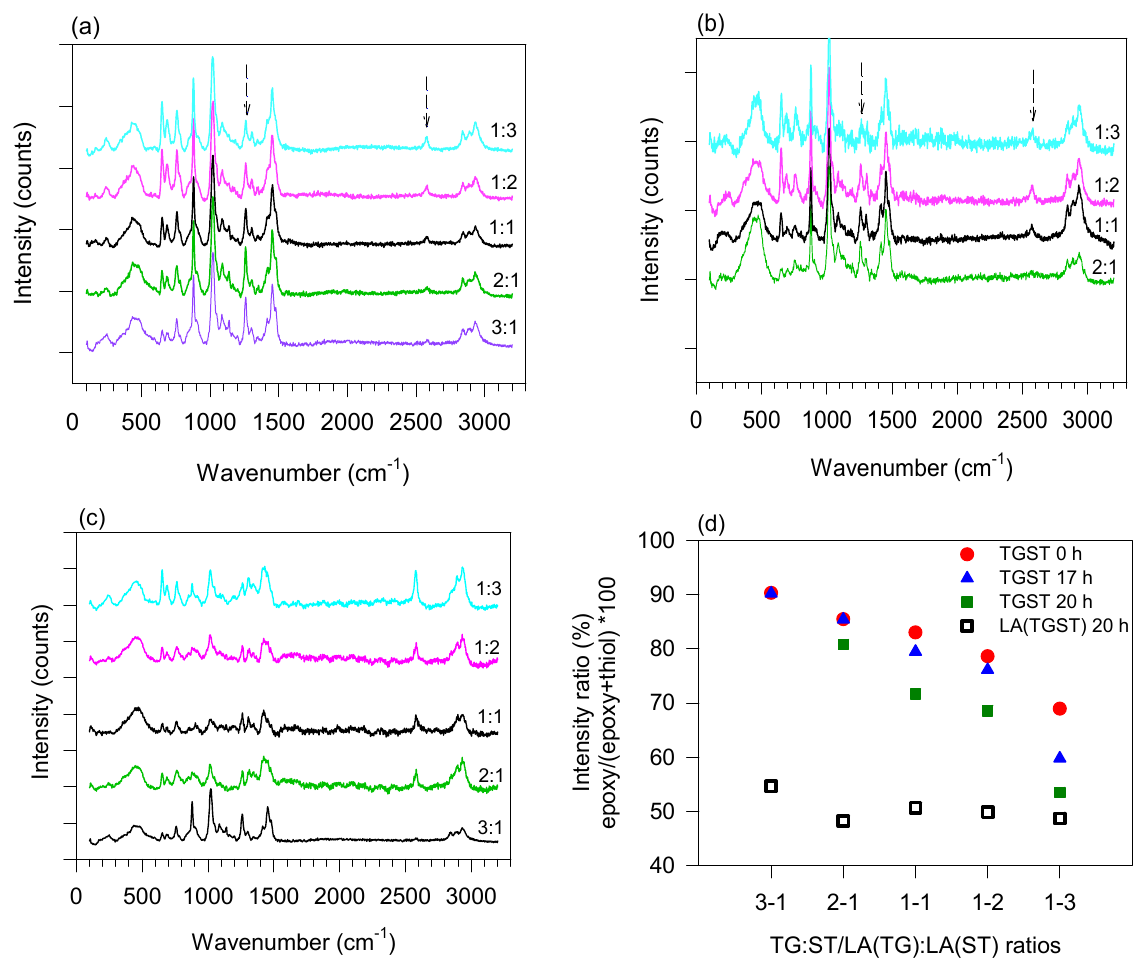
Table 1. Variation of extent of curing in TGST formulations with changing epoxy–thiol stoichiom- etry.